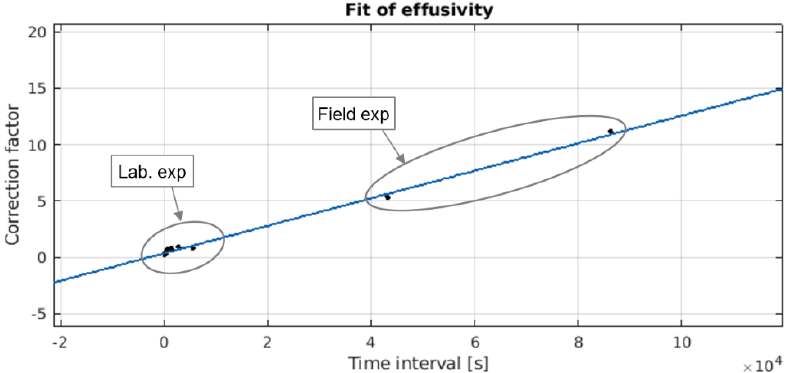
Figure 4. Plot of the correction factors determined by the method depicted above. Note that the shorter time periods were determined in the laboratory experiments and the 24 h and 12 h correction factor was determined in the field experiment.